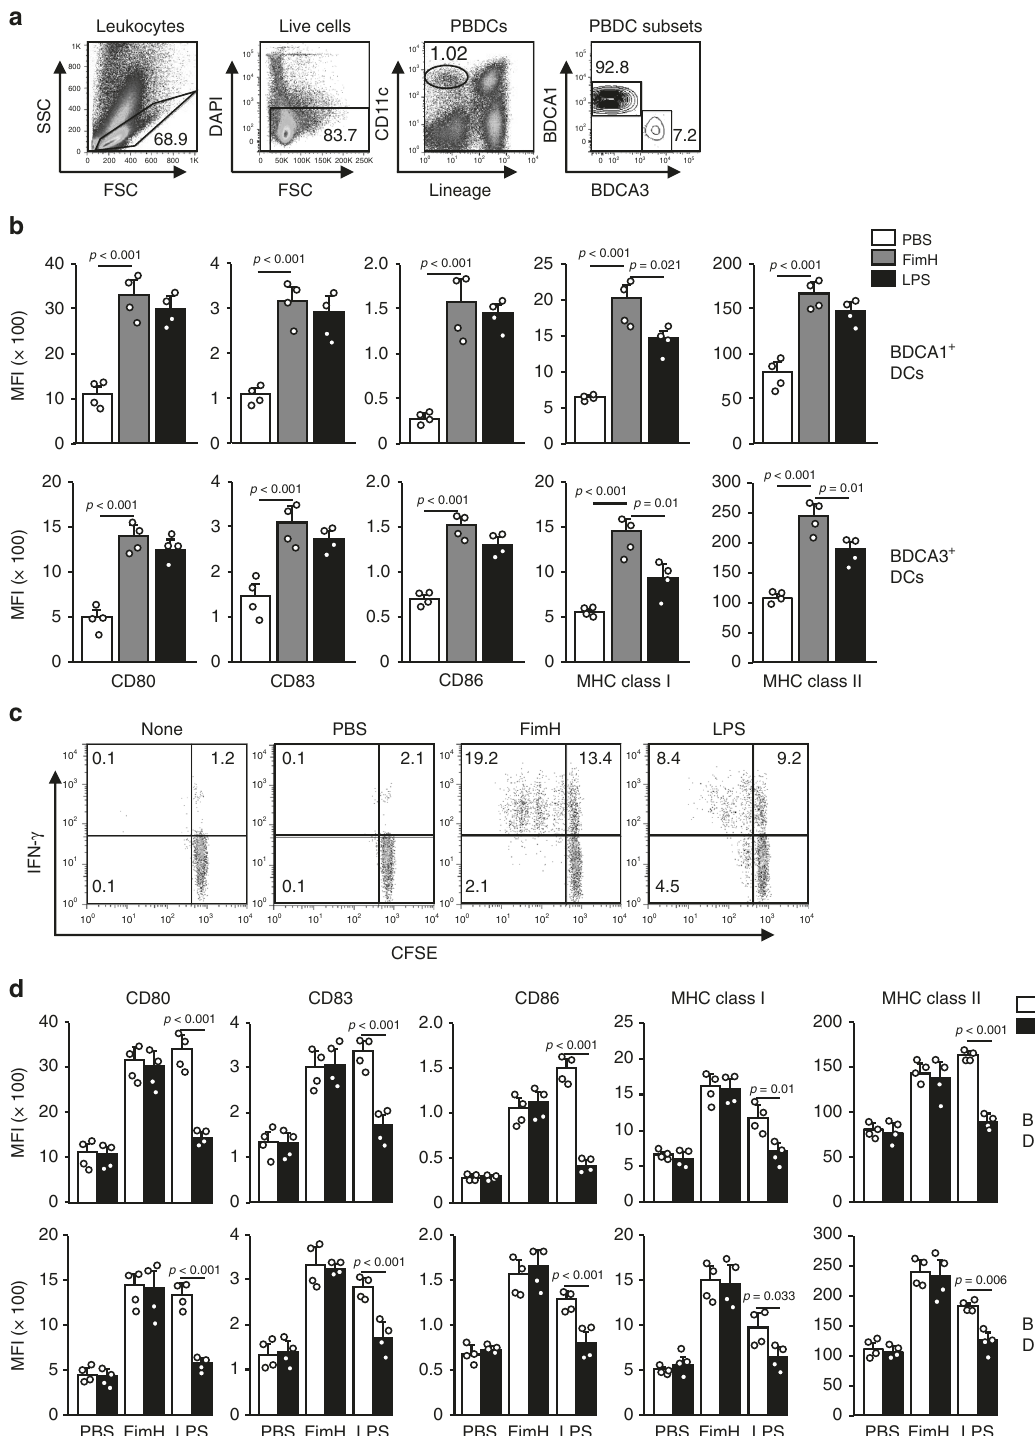
PBS Fig. 8 FimH induces human peripheral blood DC (PBDC) activation. Peripheral blood mononuclear cells (PBMCs) were treated with 5 μ g per ml of FimH and 2 μ g per ml of LPS for 24 h. a The distinctness of the PBDCs from the PBMCs is shown. The lineage markers included CD3, CD14, CD16, CD19, CD20, and CD56. b The expression levels of costimulatory molecules and MHC classes I and II in BDCA1 + (upper panel) and BDCA3 + DCs (lower panel) are shown. ( n = 4 donors, one-way ANOVA, mean ± SEM). c Syngeneic CD4 T cell proliferation and IFN- γ production were measured after co-cultured with stimulated BDCA1 + DCs and T cells. d PBMCs were pre-treated with 20 μ M MD2 inhibitors for 30 min and subsequently treated with FimH and LPS. The expression of costimulatory molecules and MHC class I and II in BDCA1 + (upper panel) and BDCA3 + DCs (lower panel) are shown. ( n = 4 donors, one- way ANOVA, mean ±